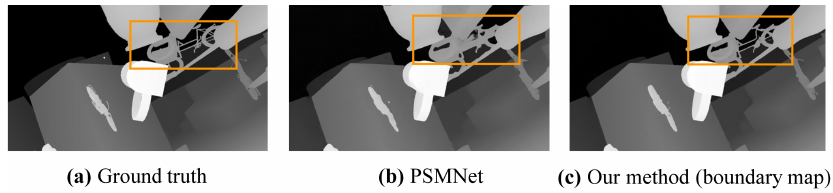
Figure 6. Qualitative result of adding boundary map as input. ( a ) is the ground truth, ( b ) is the result of baseline model, and ( c ) is the disparity result of our method with boundary map.